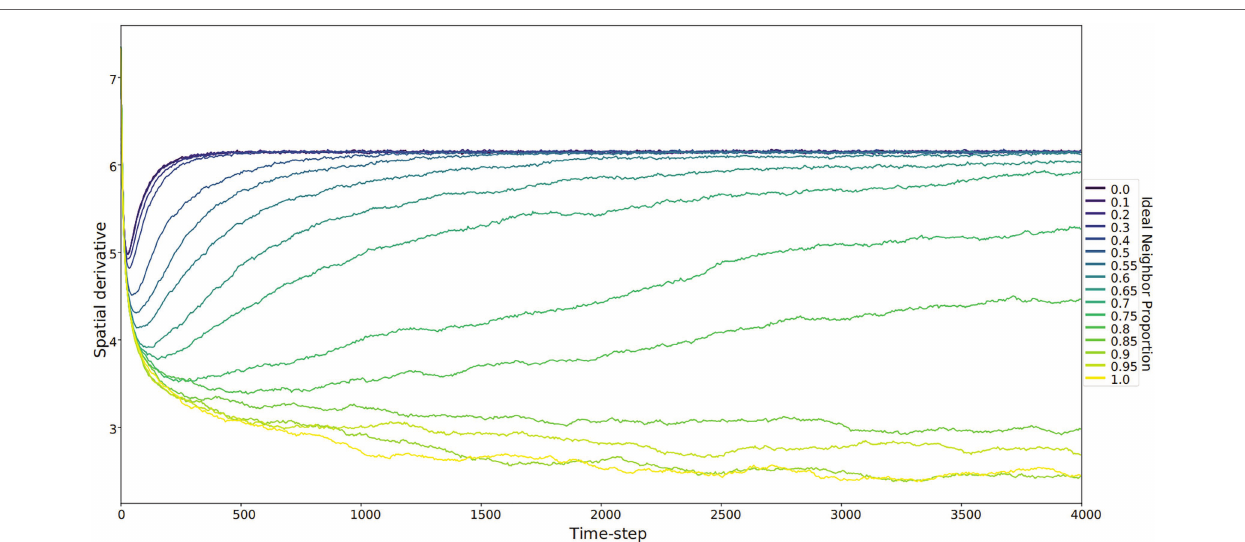
FIGURE 4 | The spatial derivative – calculated as the sum of the Sobel operator, which identifies boundaries between culture types – over time. This sum represents the unevenness of the cultural landscape, averaged for five runs at each ideal neighbor proportion. The larger this value is, the more heterogeneous the landscape. These larger values correspond to lower ideal neighbor proportions (blue lines) – populations in which individuals with uncommon culture types have greater reproductive success. Lower spatial derivative values indicate more homogeneous cultural landscapes, including larger regions with only one culture type. Within these regions, all learners will either learn the only available type or rarely invent a new culture